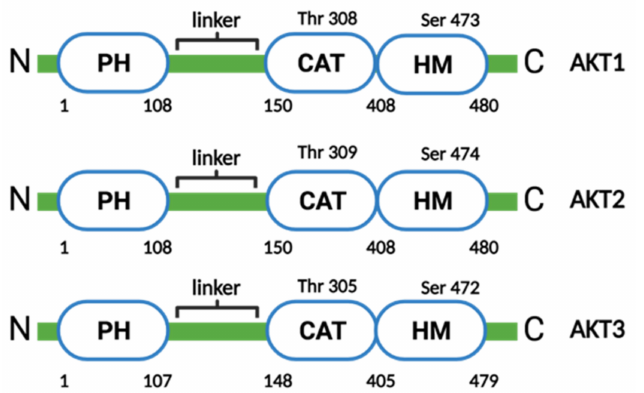
Figure 3. Structure of human AKT family isoforms (created with BioRender.com). Each family member consists of a pleckstrin homology (PH) domain, a catalytic (CAT) domain and a hydrophobic motif